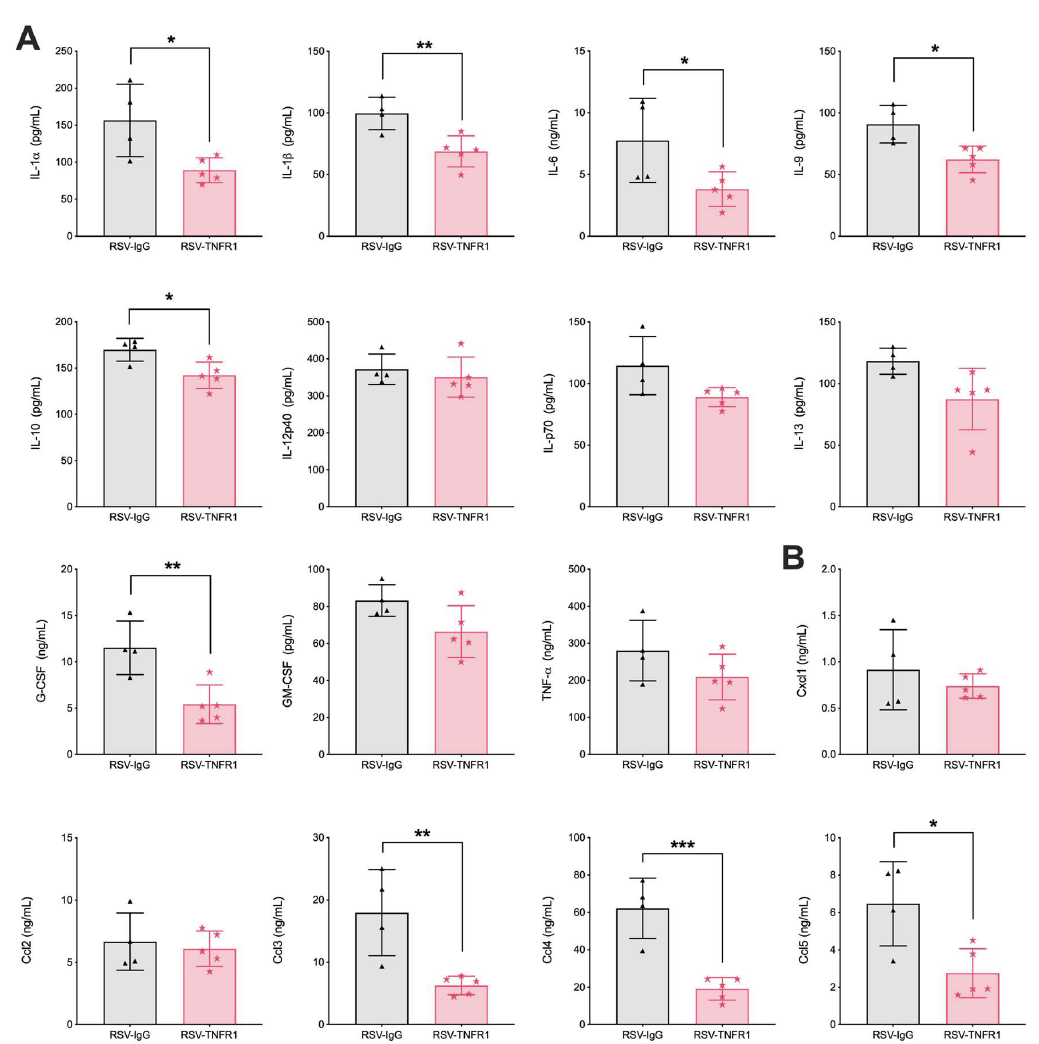
Figure 9. Post-infection blockade of TNFR1 reduces cytokines associated with severe RSV infections. BALF was collected at day one p.i. and analyzed for ( A ) cytokines and ( B ) chemokines by Bio-plex. Data are representative of one independent experiment. Data are expressed as mean ± SD. Significant results as compared to the respective control are marked with asterisks (* for p ≤ 0.05, ** p ≤ 0.01, *** p ≤ 0.001). 3.6. Blockade of TNFR1 after RSV Infection Does Not A ff ect Cell Death or Lung